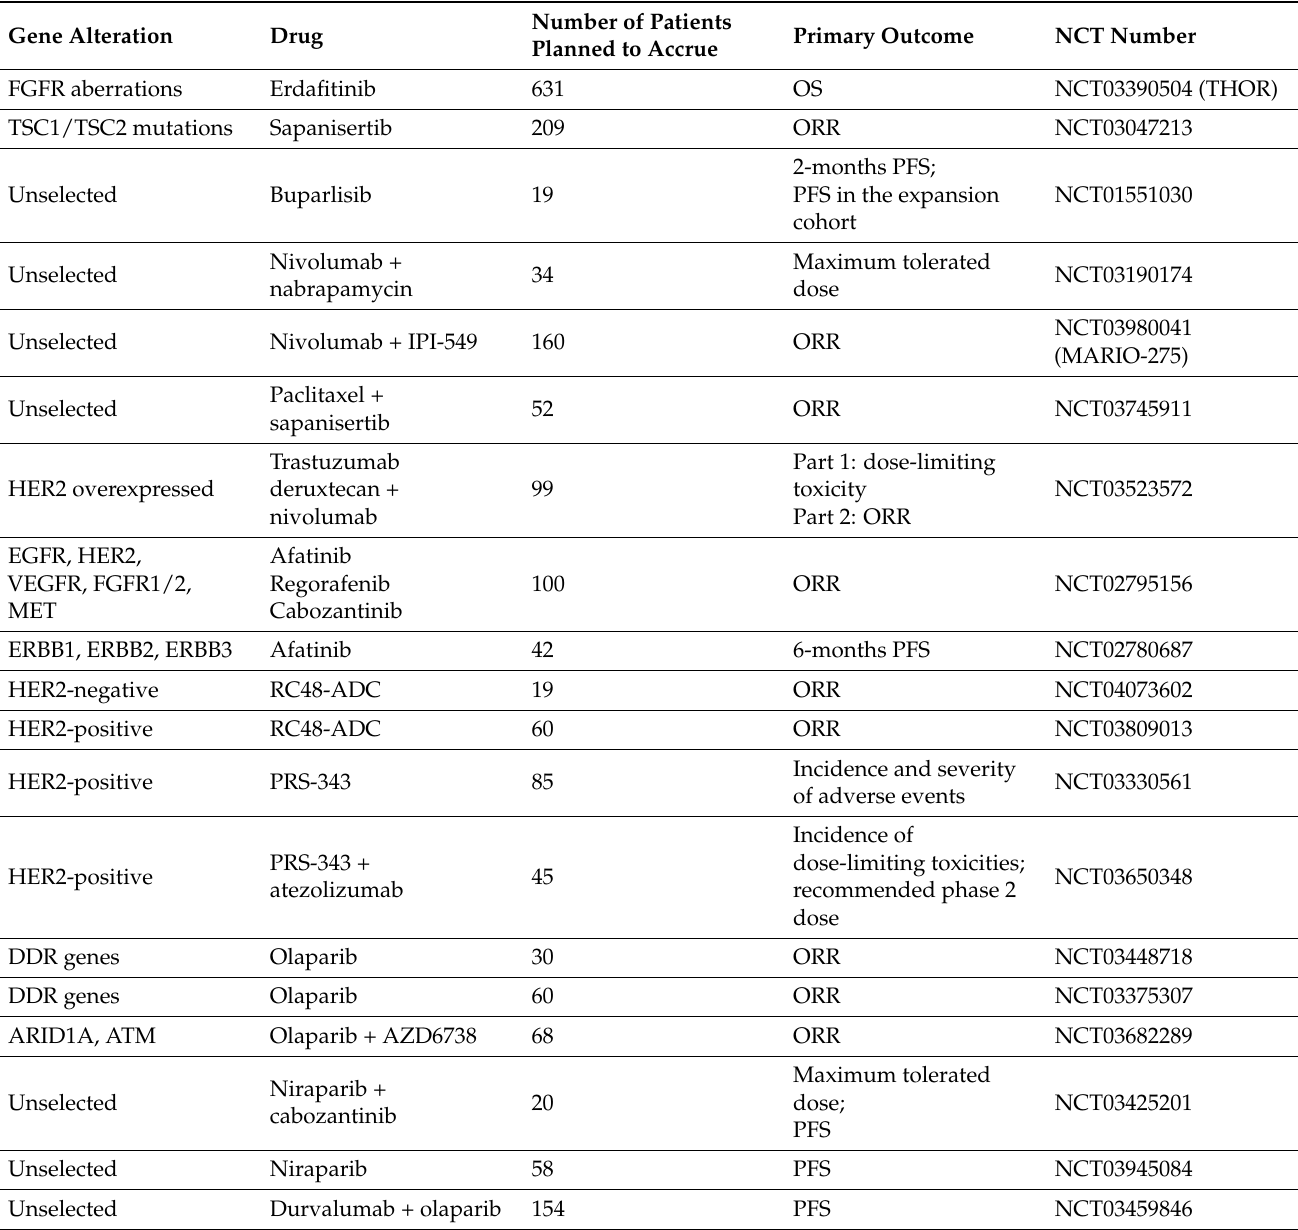
Table 2. Ongoing trials of targeted